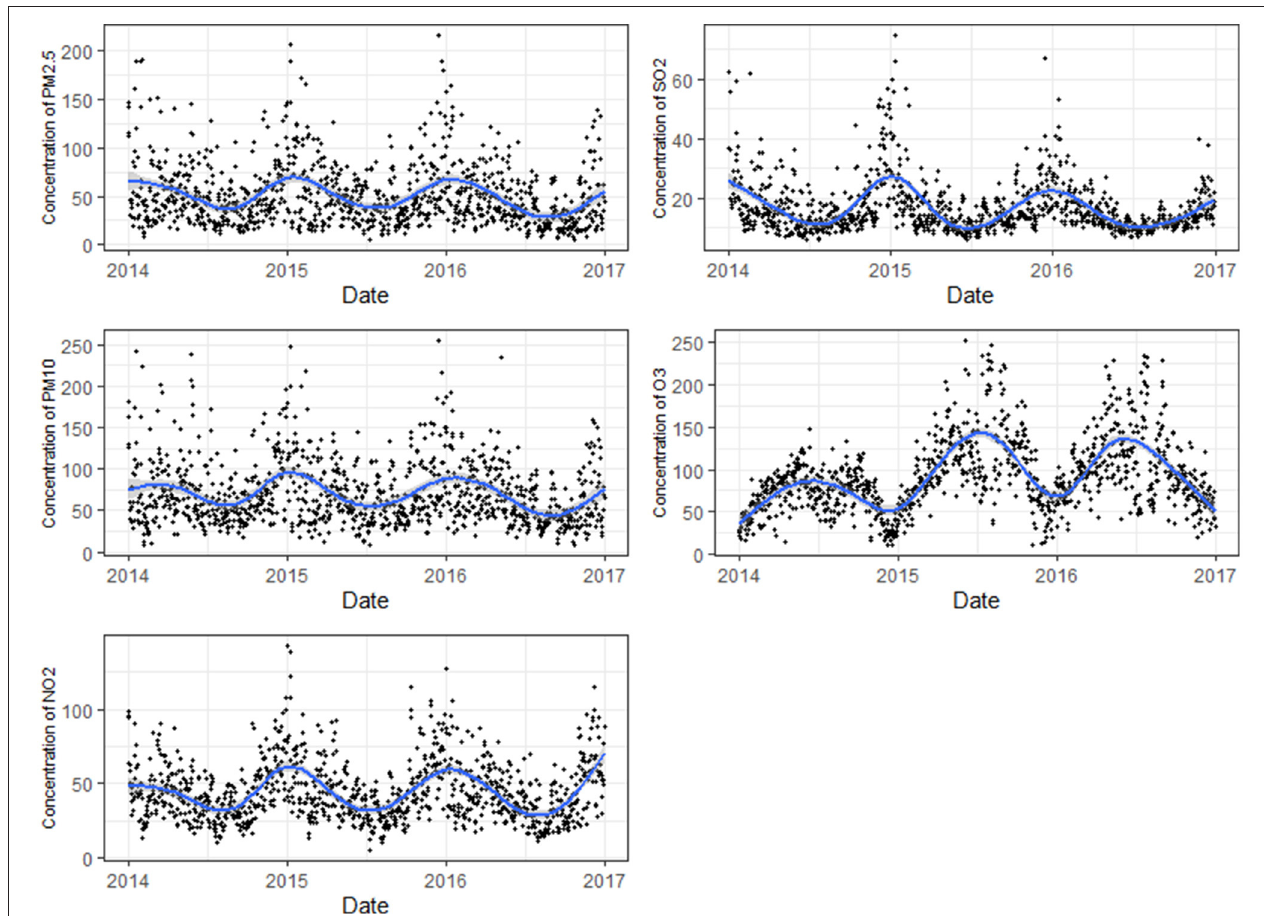
FIGURE 2 | Concentrations of air pollutants in Shanghai during 2014–2016.